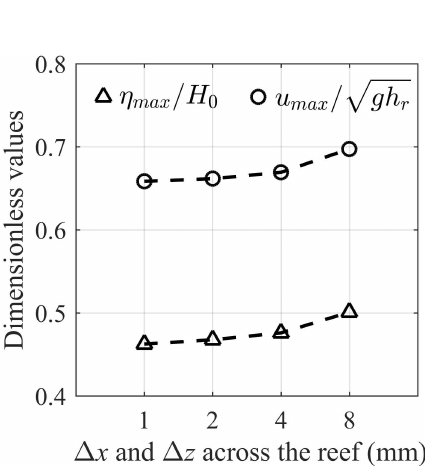
Figure 2. Numerical grids and boundary conditions of the numerical domain.